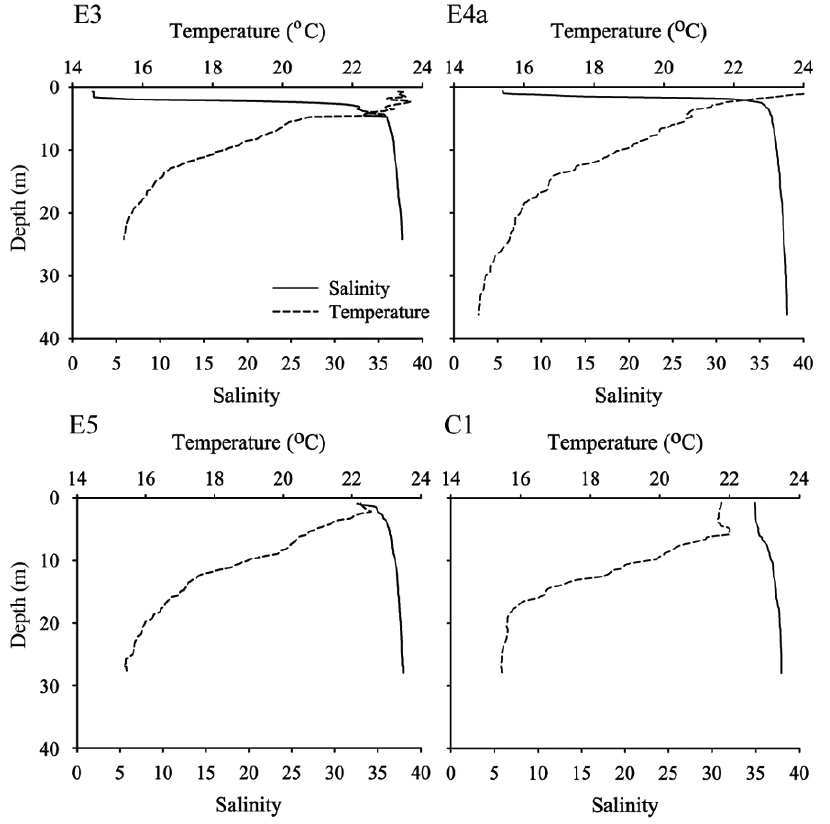
Fig. 2. – Vertical profiles of temperature (dashed line) and salinity (solid line) at the sampled stations.